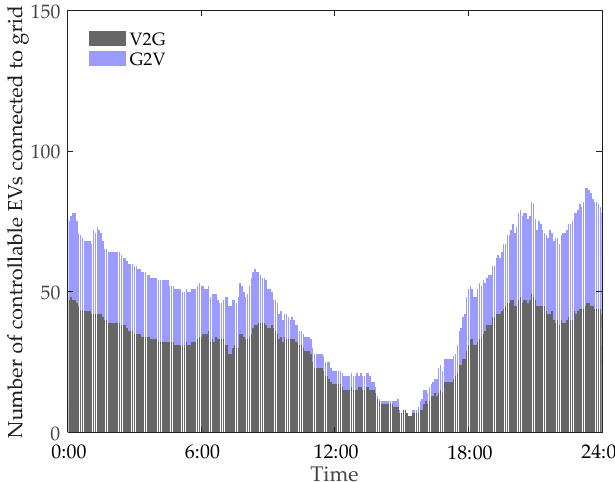
Figure 9. Total load power fluctuation rate.